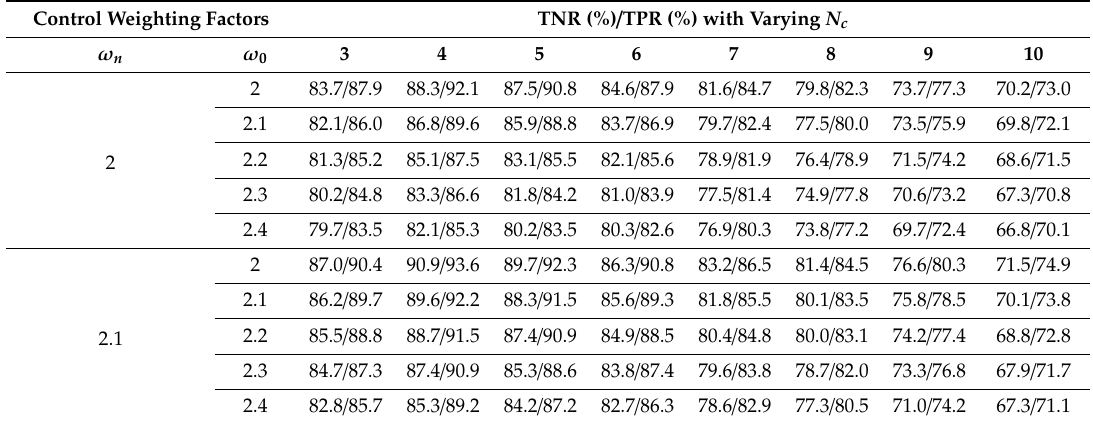
Table 3. Performance evaluation of the binary detection model using CGAN-IFCM with varying N c , ω n , and ω 0 values with the VOICED database. (a) Fixed ω n = 1.8. (b) Fixed ω n = 1.9. (c) Fixed ω n = 2.0. (d) Fixed ω n = 2.1. (e) Fixed ω n =